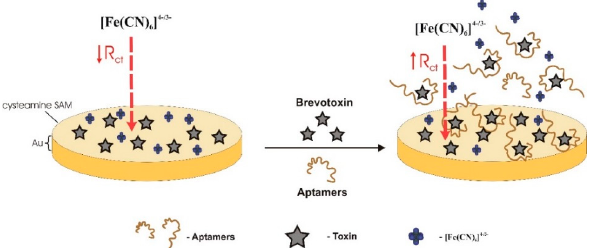
Figure 11. Label-free impedimetric competitive biosensor for brevetoxin-2 (BTX-2), developed by Eissa et al. [37], where competition is established between the BTX-2 immobilized on the self-assembled monolayer (SAM) of cysteamine on a gold electrode surface, and the free BTX-2 in solution, at a specific aptamer concentration. The change of charge transfer resistance (R ct ) of the [Fe(CN) 6 ] 4 − /3 − redox couple is the signal for electrochemical